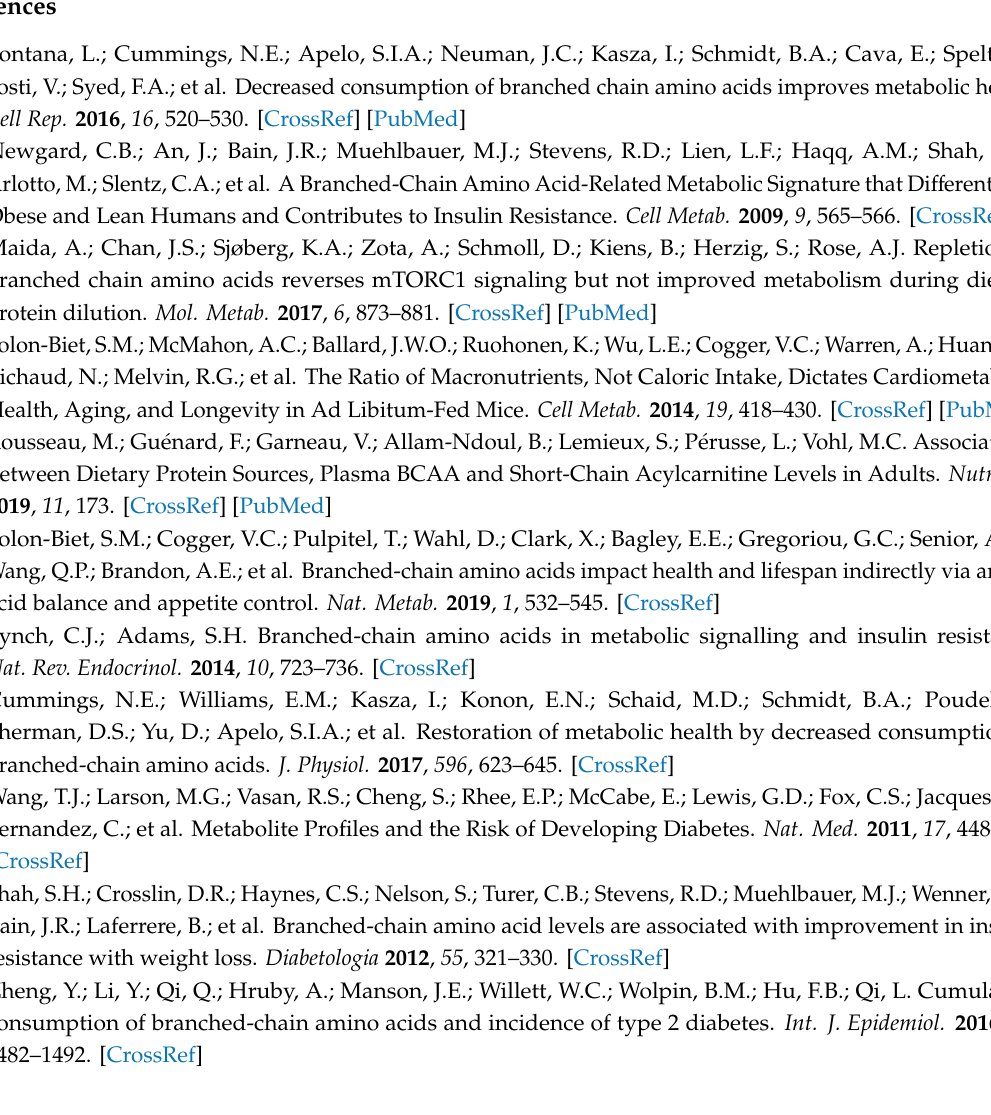
Figure S1: Circulating BCAAs and age, PASE, number of morbidities, smoking status and source of